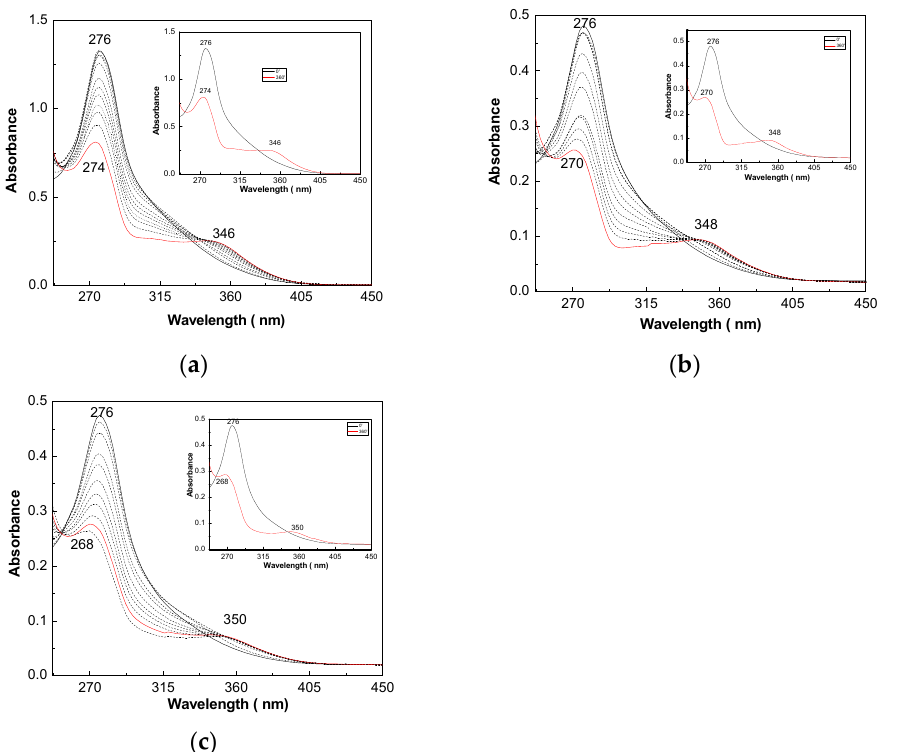
Figure 1. UV-VIS spectra of the solutions: ( a ) 1 mL AZA (1.52 × 10 − 4 M) and 1 mL ST (5.6 × 10 − 5 M); ( b ) 1 mL AZA (10 − 4 M) and 1 mL ST (1.12 × 10 − 4 M); and ( c ) 1 mL AZA (10 − 6 M) and 1 mL ST (3.38 × 10 − 4 M) under UV light for a time of 360 min. The inserts show the UV-VIS spectra in dark conditions (continue black curve) and after 6 h of UV irradiation of the AZA:ST samples (red curve). The dashed black curves correspond to the UV-VIS spectra recorded successively every 36 min of exposure to UV light for 6 h.